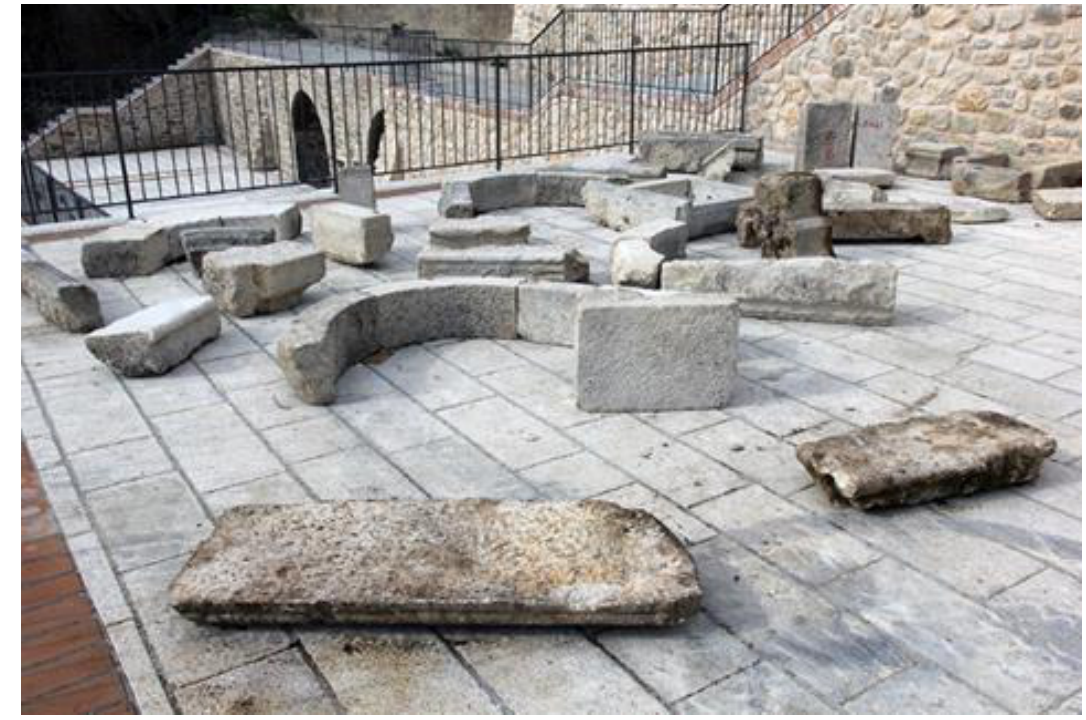
Figure 15. Conza della Campania: detail of the Archaeological Park (photos by [35,36]).